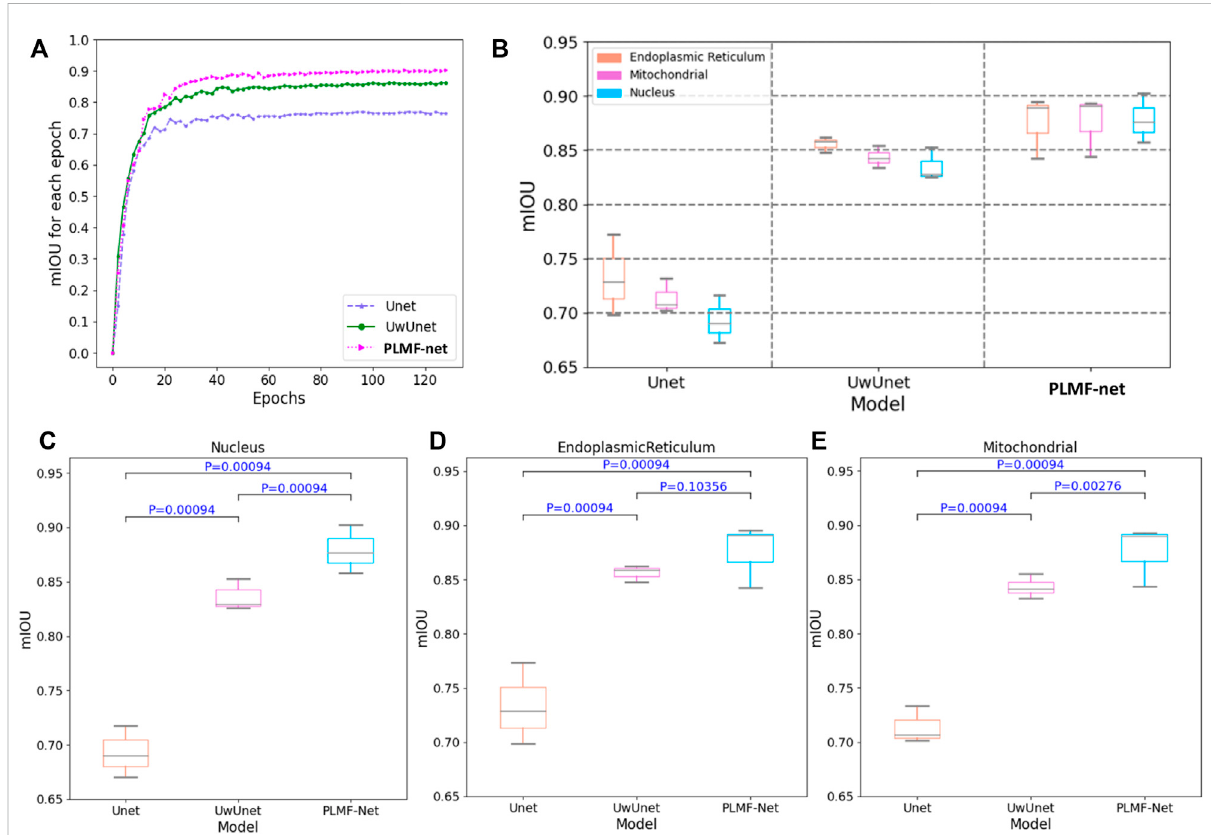
FIGURE 9 Themean intersection overunion(mIoU)ofdifferentdeep-learningmodelsoverall SRSmicroscopy images inthe fi xedlung cancercell (A549, fromATCC)detectiondataset. (A) mIoUforeachepochcomparisonamongdifferentmethods.Unet(purpletriangledashline),UwUnet(greencircle solid line), PLMFNet (pink arrow dotted line) represent Unet, UwUnet, and PLMFNet, respectively; (B) Box plot of mIoU accuracy over all organelle (nuclei,mitochondria,andendoplasmicreticuli)predictiontasksetswiththePLMFNet-basedlearningmodelandcomparedwiththatofvarious deep neural network-based prediction models such as Unet and UwUnet learning models. (C) Box plot of mIoU accuracy on the nuclei prediction task set with PLMFNet-based learning model and compared with that of varied deep neural network-based prediction models such as Unet and UwUnet learning models on all. Horizontal bars depict Mann – Whitney U tests for signi fi cance of differences in the mIoU value between different deep-learning models (corrected p < 0.001; not signi fi cant p > 0.05). (D) The box plot of mIoU accuracy on the endoplasmic reticuli prediction task set with the PLMFNet-based learning model and compared with that of varied deep neural network-based prediction models such as Unet and UwUnetlearningmodels.HorizontalbarsdepicttheMann – WhitneyUtestsforsigni fi canceofdifferencesinthemIoUvaluebetweendifferentdeep- learning models (corrected p < 0.001; not signi fi cant p > 0.05). (E) The box plot of mIoU accuracy on the mitochondria prediction task set with PLMFNet-basedlearningmodelandcomparedwith thatofvarieddeep neuralnetwork-basedprediction